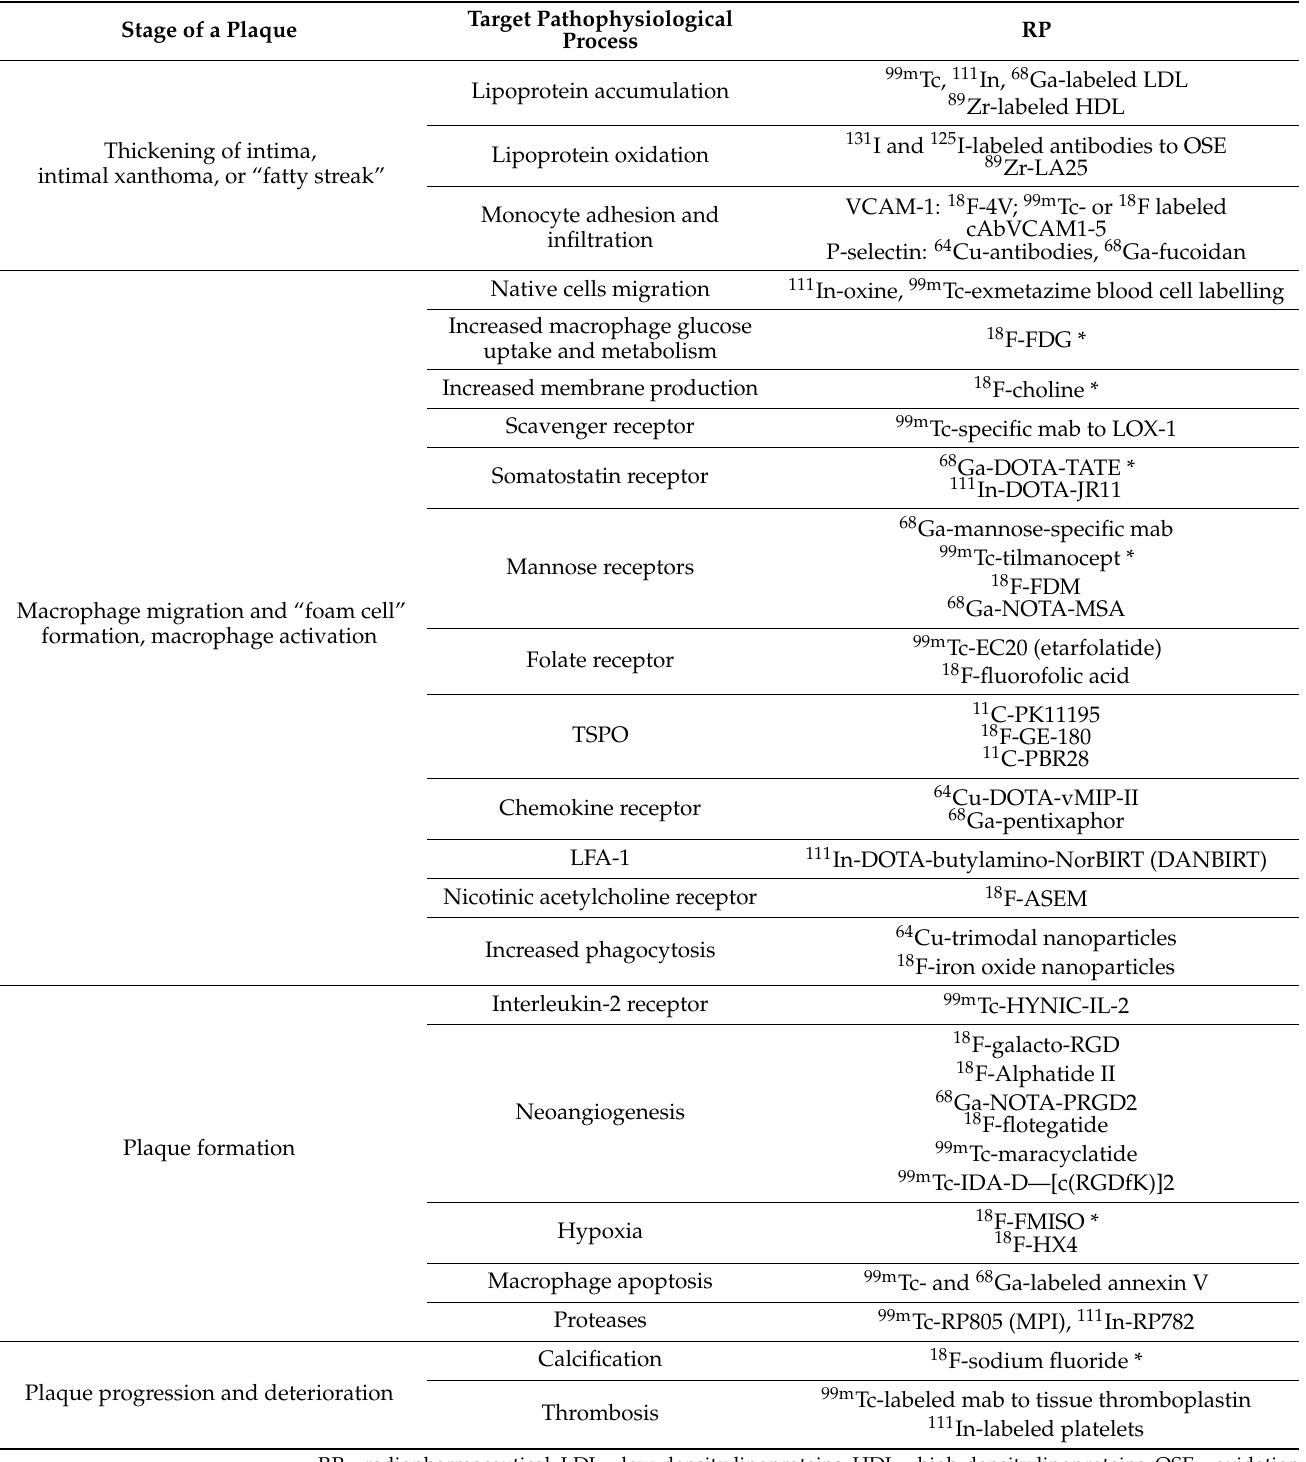
Table 1. The main pathophysiological mechanism used for atherosclerotic plaque imaging at each